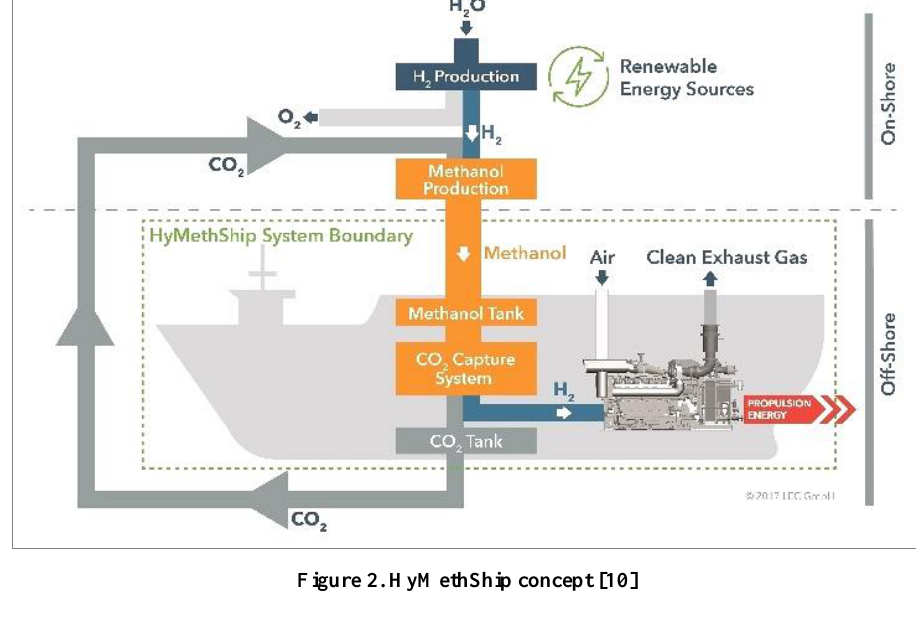
Figure 2. HyMethShip concept [10]